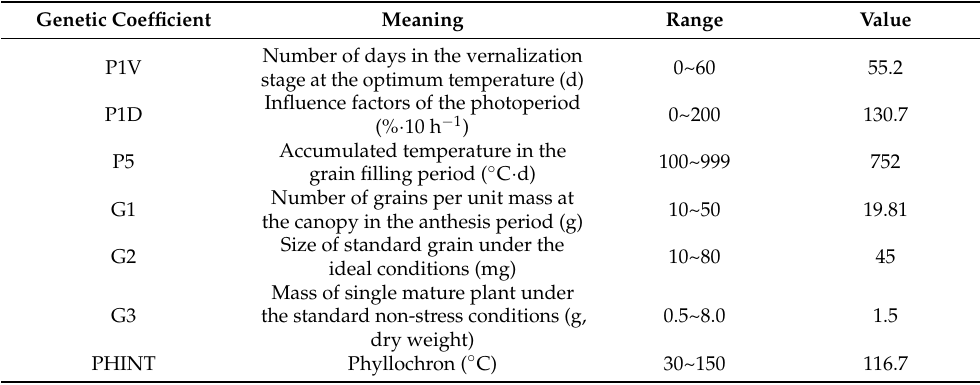
Table 5. Parameters of DSSAT winter wheat variety, Jimai